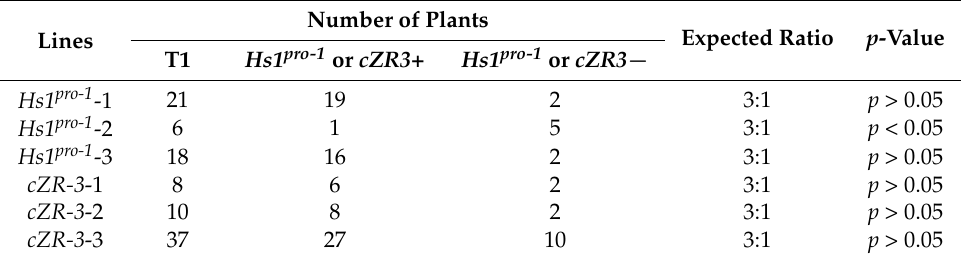
Number of Plants